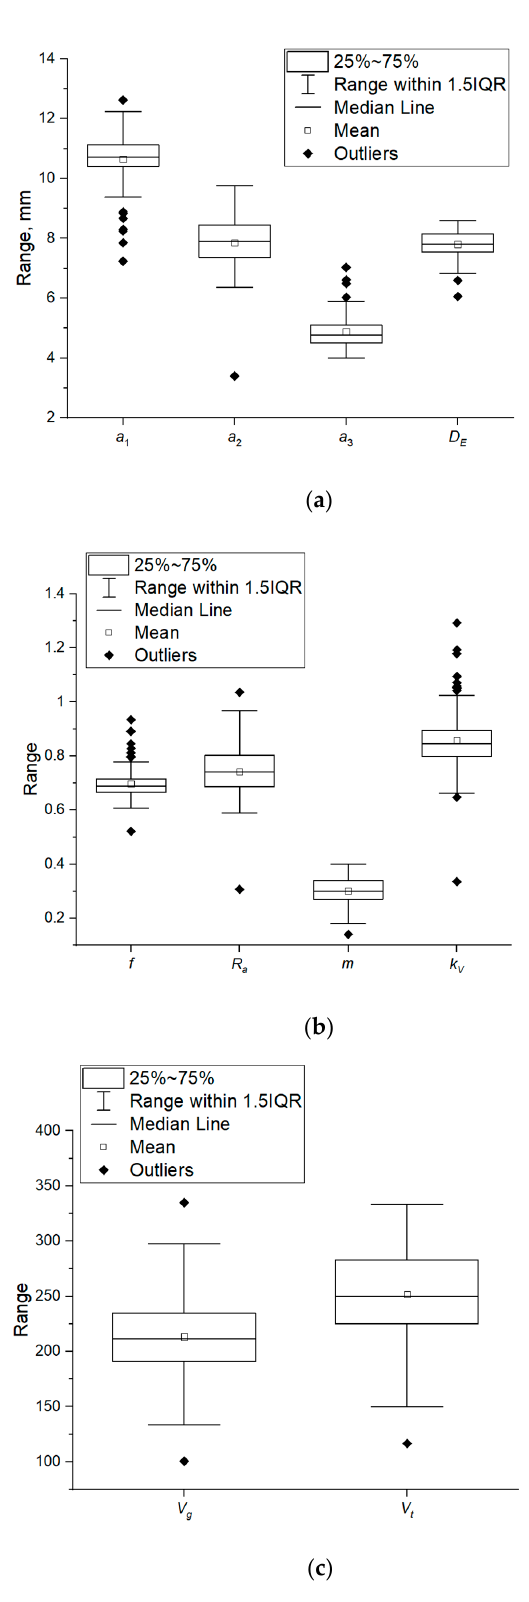
Figure 4. Box charts of values of the selected physical properties of corn grains, ( a ) properties connected with size: length ( a 1 ), volume-equivalent sphere diameter ( D E ), width ( a 2 ), and height ( a 3 ), ( b ) properties connected with shape and volume: aspect ratio ( R a ), sphercity index ( f ), mass ( m ), volume correction factor ( k V ), ( c ) grains volume: true volume ( V t ), geometric volume ( V g ).